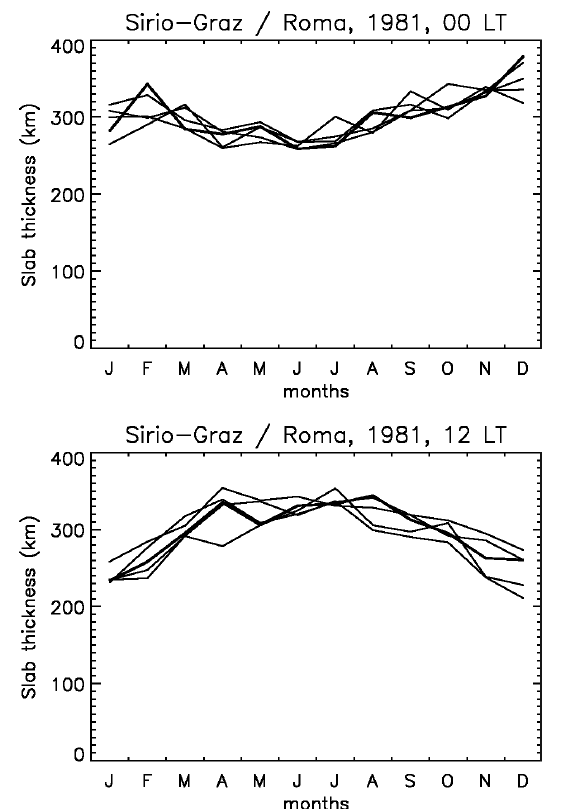
Fig. 9.1. Annual variation of equivalent slab thickness for 1981 from the combination of vertical electron con- tent measured by means of the Faraday effect on the VHF signal of SIRIO at Graz (latitude of ionospheric point 42.5°N) and peak electron density from the ionosonde data of Roma (41.9°N, 12.5°E). Upper panel: 0 LT; low- er panel: 12 LT (Leitinger, 1998). The different curves have been gained with the lower and upper deciles, low- er and upper quartiles and with the